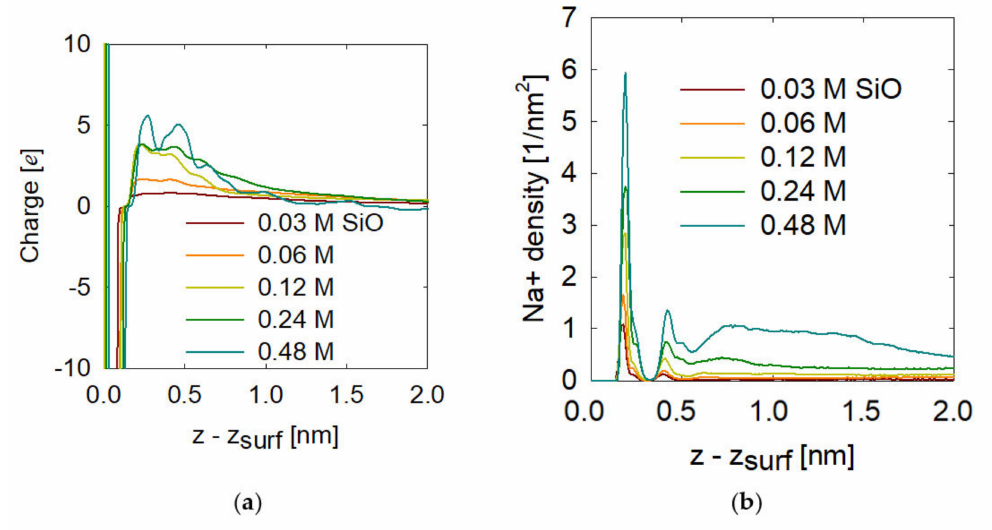
Figure 7. ( a ) Charge and ( b ) Na + density profile for the hematite (001) surface for all the concentrations of